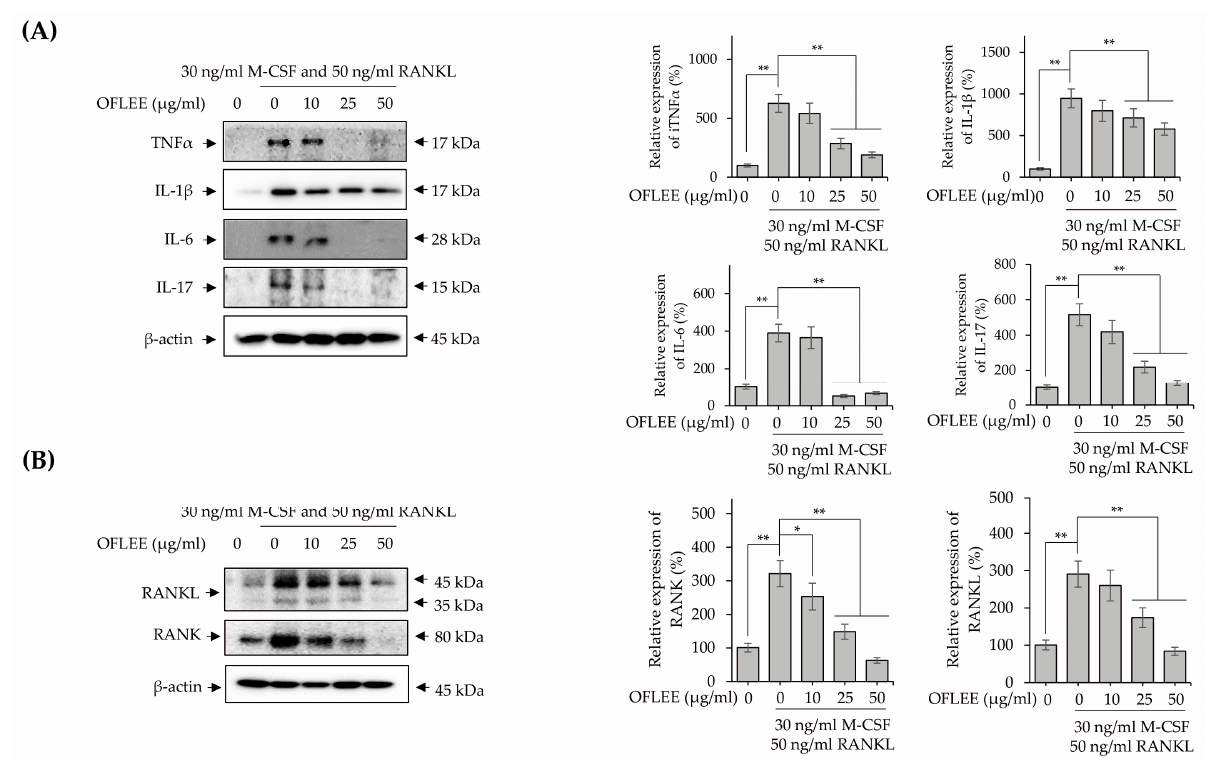
Figure 6. OFLEE down-regulated the expression of pro-inflammatory cytokines associated with the osteoclastogenesis in the BMMs treated with M-CSF and RANKL. BMMs were treated with 0, 10, 25, and 50 μ g/mL OFLEE in the presence of 30 ng/mL M-CSF and 50 ng/mL RANKL for 72 h. Thereafter, Western blot was performed to verify the expression of TNF α , IL-1 β , IL-6, IL-17, RANKL, and RANK. β -actin was used as an internal control. ( A , B ) OFLEE down-regulated the expression of pro-inflammatory cytokines including TNF α , IL-1 β , IL-6, IL-17, RANKL, and RANK in the BMMs treated with M-CSF and RANKL. Results are mean ± SD of three independent experiments (n = 3), * p < 0.05 and ** p < 0.01.